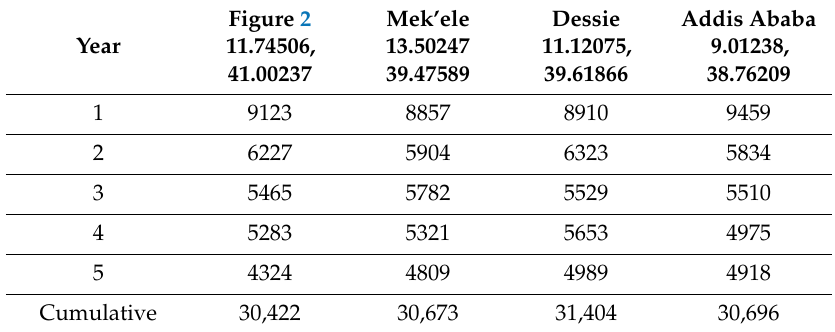
Table 3. Comparison of annual average profit (k$) and five-year cumulative profit for four di ff erent locations of the service center, all other input parameters being the same.